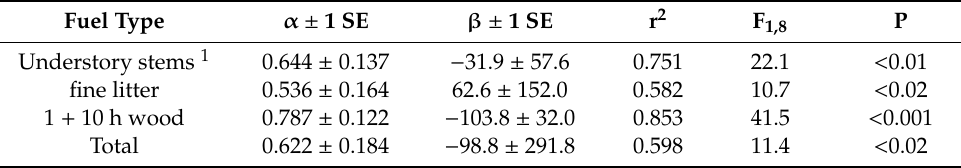
Figure 3. The relationship between pre-burn loading and consumption of surface and understory fuels estimated from 1.0 m 2 plots (n = 10 to 32 in each burn) for the eight prescribed fires. Linear models and statistics are shown in Table 3, and all data are presented in Table A1. Lines indicate linear models for the relationships between pre-burn loading and consumption for each fuel type and for total surface and understory fuels. Table 3. Linear models of pre-burn loading and consumption of understory vegetation, fine litter on the forest floor, woody fuels on the forest floor, and total surface and understory fuels during the eight prescribed fires. Data are shown in Figure 3 and were fit to the equation, consumption = α × initial mass + β ; the units are g m − 2 .